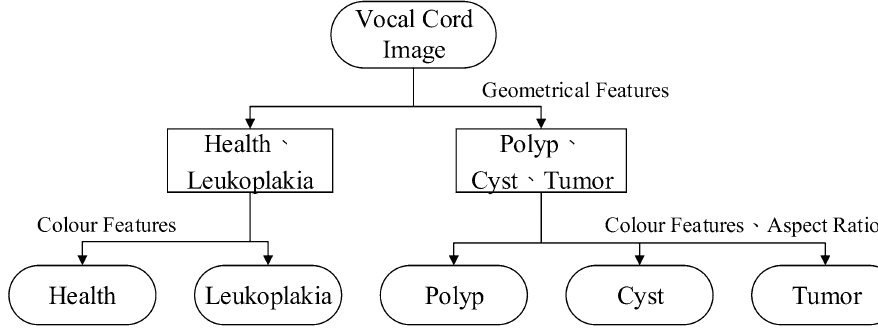
Figure 6. Lesion classification model.